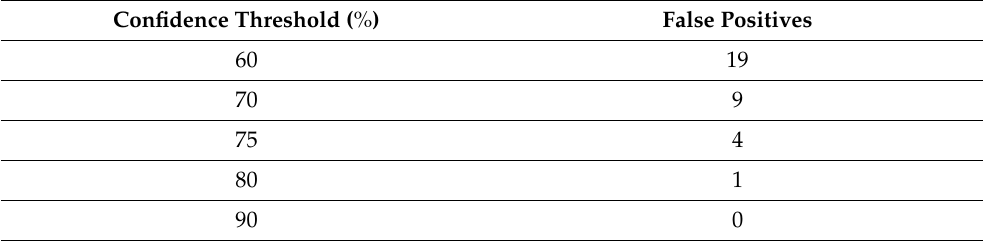
Table 3. False positive evaluation on an external